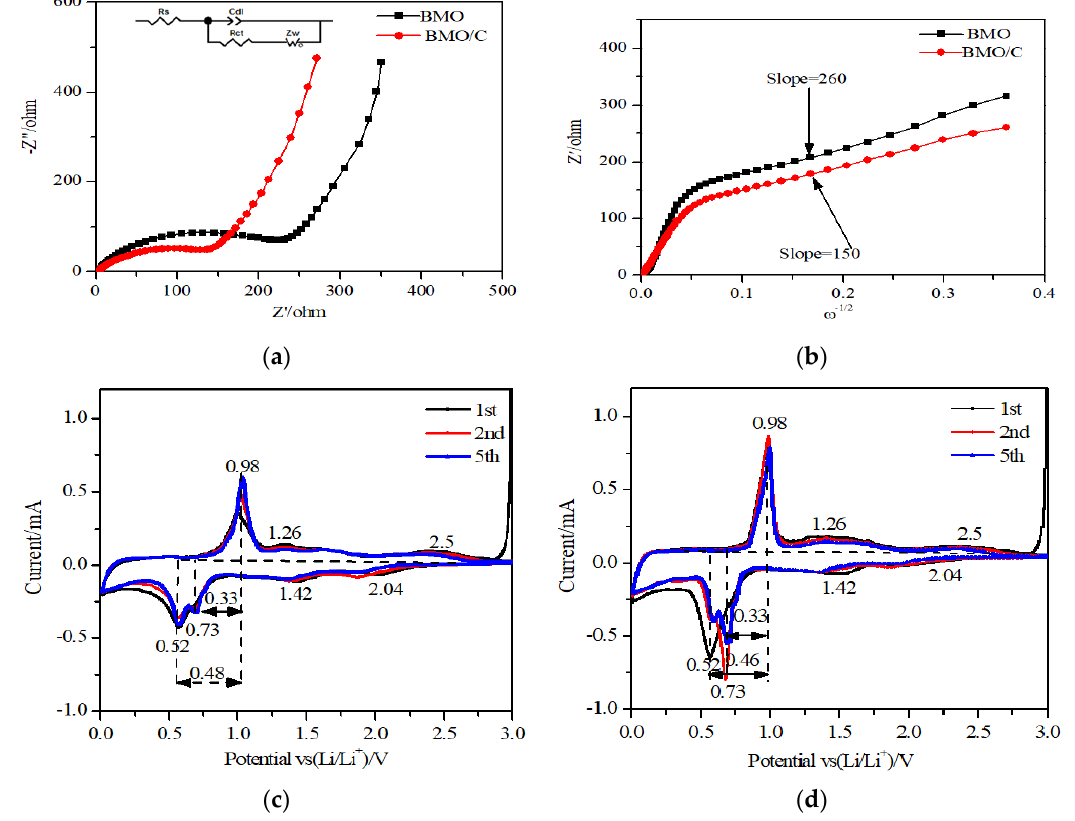
Figure 7. ( a ) electrochemical impedance spectra (EIS) of the BMO and BMO / C; ( b ) linear fitting of Warburg impedance of the BMO and BMO / C electrodes; cyclic voltammograms and FWHM for the 1st, 2nd and 5th cycles of ( c ) BMO and ( d ) BMO / C electrodes at the rate of 0.1 mVs − 1